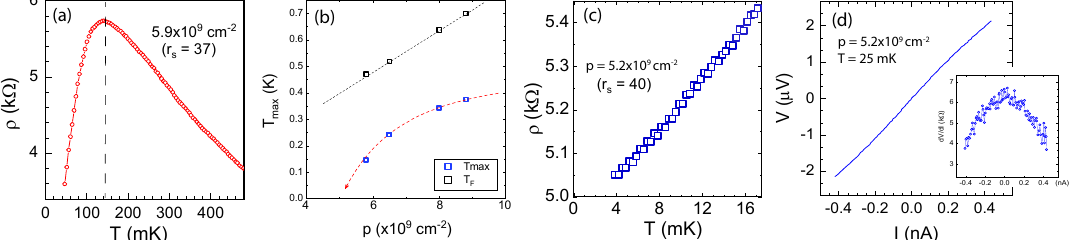
Figure 1. ( a ) T dependence of the sheet resistance for r s = 37 down to 40 mK and ( b ) The p dependence of T max in comparison to E F . ( c ) ρ ( T ) for r s = 40 down to 4 mK. ( d ) DC-IV for p = 5.2 × 10 9 cm − 2 measured at 25 mK for a current range between 0 and ± 0.4 nA. Inset: dV / dI based on the IV result. T max is sometimes associated with a renormalized Fermi energy E ∗